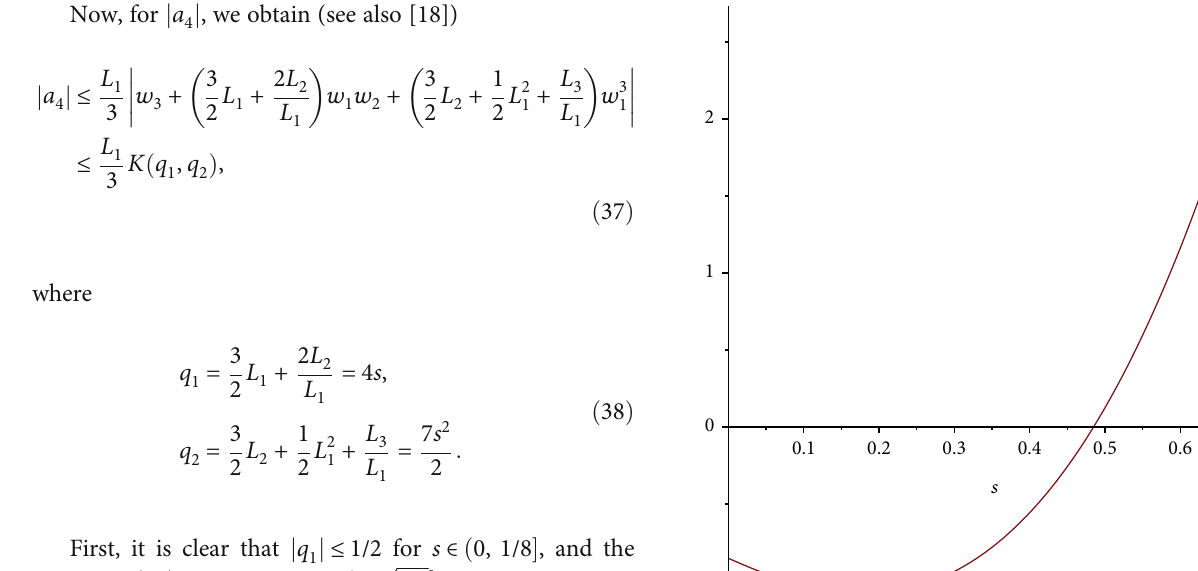
ffiffiffi p (cid:2) 2 p (cid:2) , and the fi rst 2